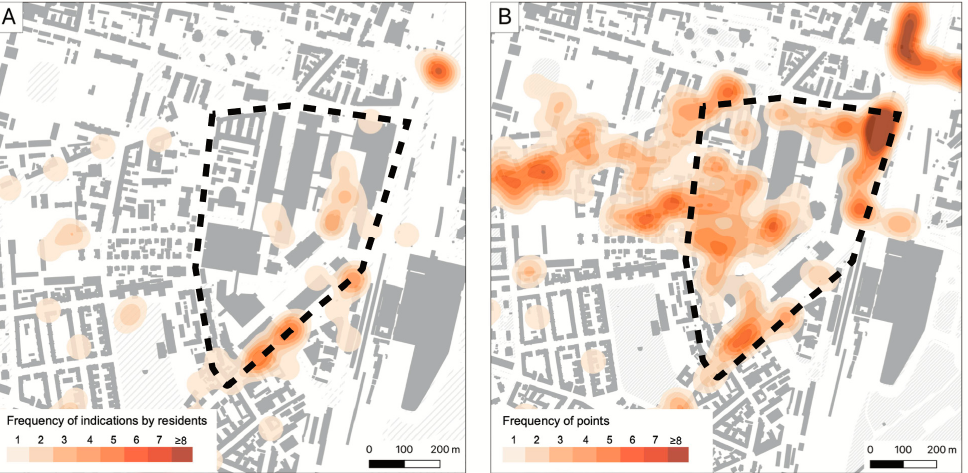
Figure 6. Comparison of places indicated by the group of residents ( A ) and urban planners ( B ) regarding areas of lack of thermal comfort—area of Poznan International Fair. The dashed black line marks the areas of difference. Source of reference data: © OpenStreetMap contributors, see: https://www.openstreetmap.org/copyright (accessed 10 February 2023).